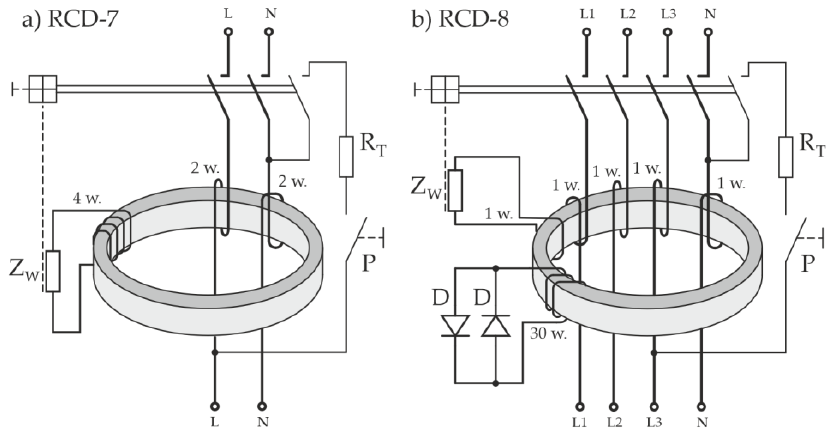
Figure 10. Diagram of the internal structure of the tested circuit breakers: ( a ) RCD-7 and ( b ) RCD-8.